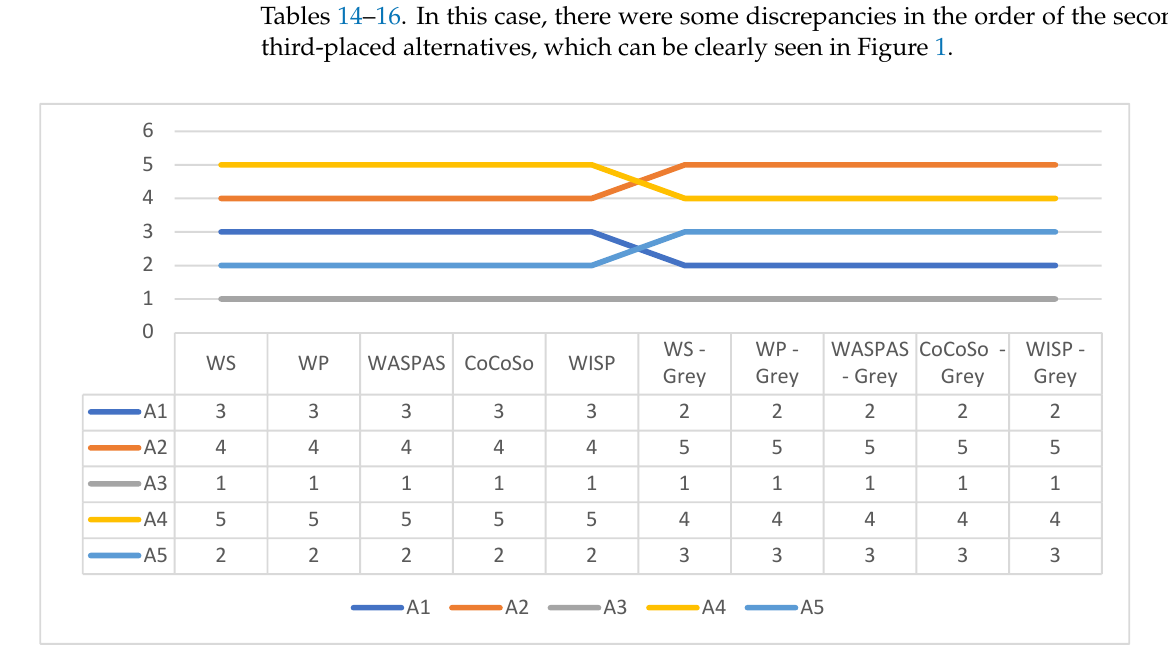
Figure 1. Ranking orders of alternatives obtained on the basis of 50 virtual respondents.